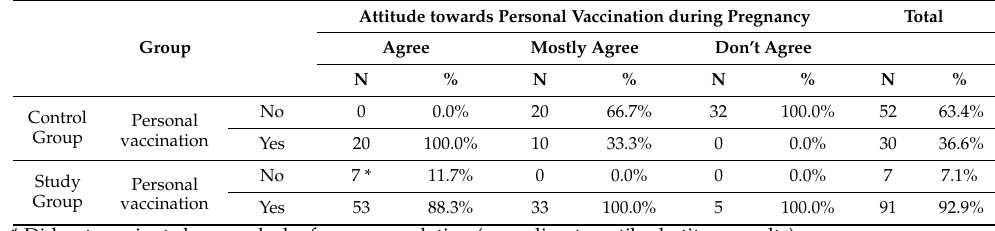
Table 2. Impact of the educational programme on the personal anti-pertussis vaccination uptake: comparison between study and control